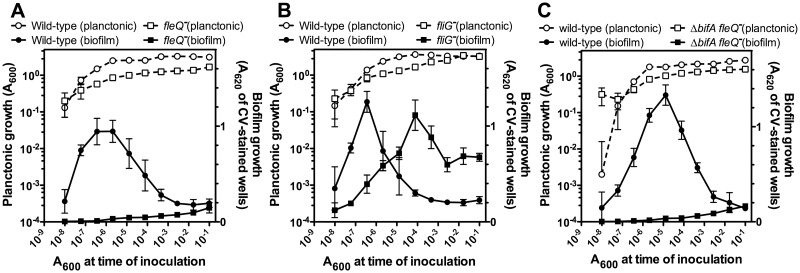
Dilution series-based growth curves of KT2442 derivatives.Planktonic (left axes, open symbols) or biofilm growth (right axes, closed symbols) is plotted against the initial A600 of each dilution. Circles represent the wild-type KT2442 strain and squares represent the fleQ mutant MRB35 (A), the fliG mutant MRB47 (B), or the ΔbifA fleQ mutant MRB50 (C). Plots display one representative experiment of at least three biological replicates. Error bars represent the standard deviation of the six technical replicates.